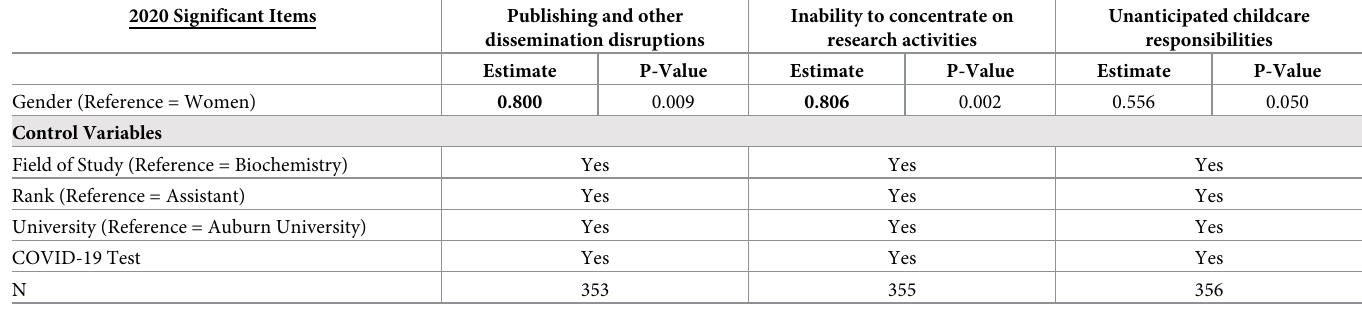
Table 4. Logistic model estimating gender differences in 2020 controlling for field of study, rank, and if the respondent tested for COVID-19.